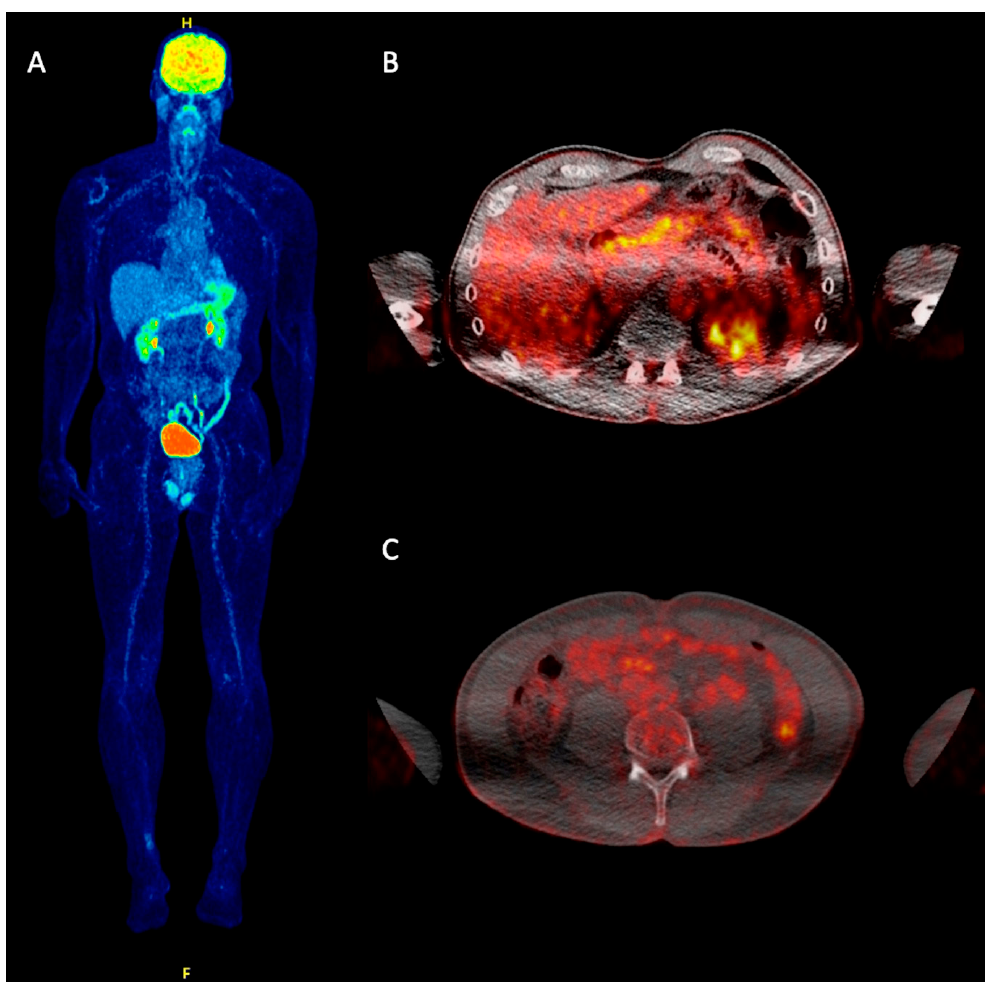
Figure 1. A 60-year-old Merkel cell carcinoma (MCC) patient referred to our department for staging purposes due to clinical suspicion of hepatic metastases. Whole-body 18 F-FDG PET maximum intensity projection (MIP) ( A ) demonstrated foci of increased tracer uptake in the liver, lumbar spine, and right femur, corresponding to metastases (arrows). Transaxial, fused 18 F-FDG PET/CT at the hepatic level ( B ) shows a focal site of increased tracer uptake in liver segment VI, corresponding to a hepatic metastasis. Transaxial, fused 18 F-FDG PET/CT of the lower abdomen ( C ) shows pathologic tracer accumulation in the fourth lumbar vertebrae, representing an osseous metastasis.